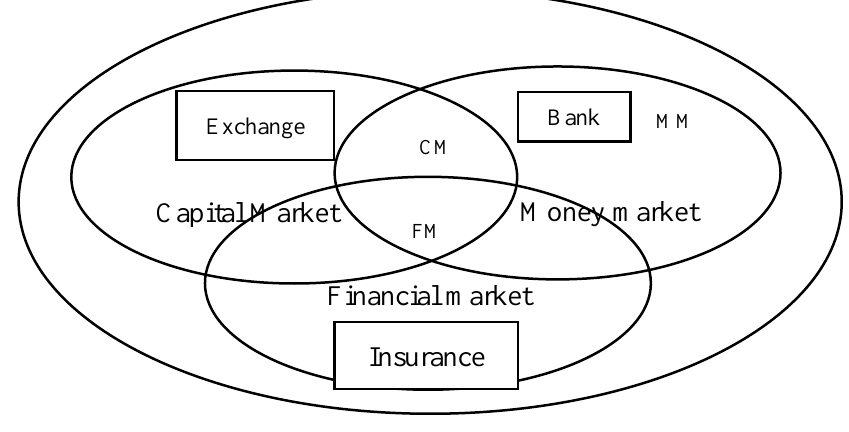
Figure 1. Types of financial markets according to the scope of activity of financial institutions (Source: Shabani,